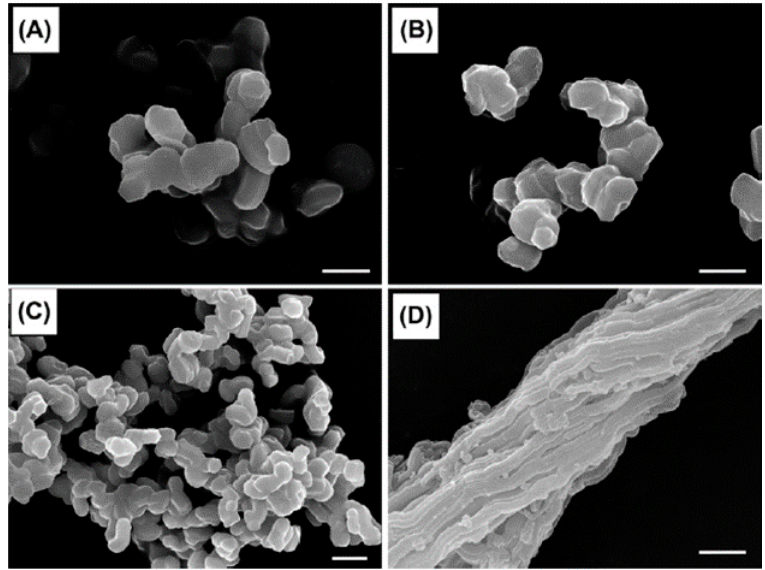
Figure 2. SEM images of various plugged SBA-15 materials of ( A ) 70 °C 1 day, ( B ) 70 °C 3 days, and ( C ) 80 °C 3 days synthesized through a one-step TEOS addition under static condition during the aging period [21], and ( D ) the plugged SBA-15 sample synthesized under stirring conditions during the aging period [26]. The scale bars are 3 µm.